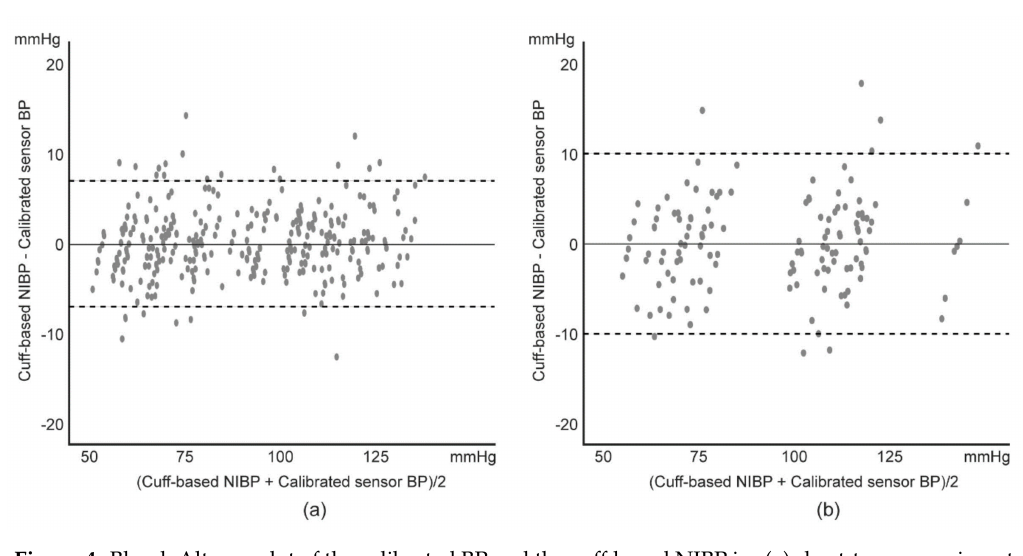
Figure 4. Bland–Altman plot of the calibrated BP and the cu ff -based NIBP in: ( a ) short-term experiment and ( b ) long-term experiment. Table 4. Statistical values of bias between the calibrated BP and the cu ff -based NIBP in the short-term and long-term experiments.